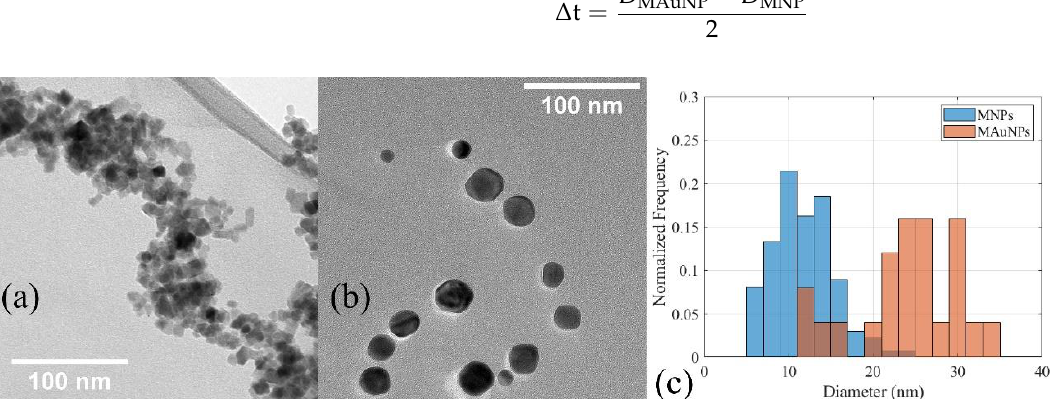
Figure 2. Representative TEM micrographs of ( a ) MNPs, ( b ) MAuNPs, and ( c ) the distribution of NP sizes as measured from TEM micrographs.